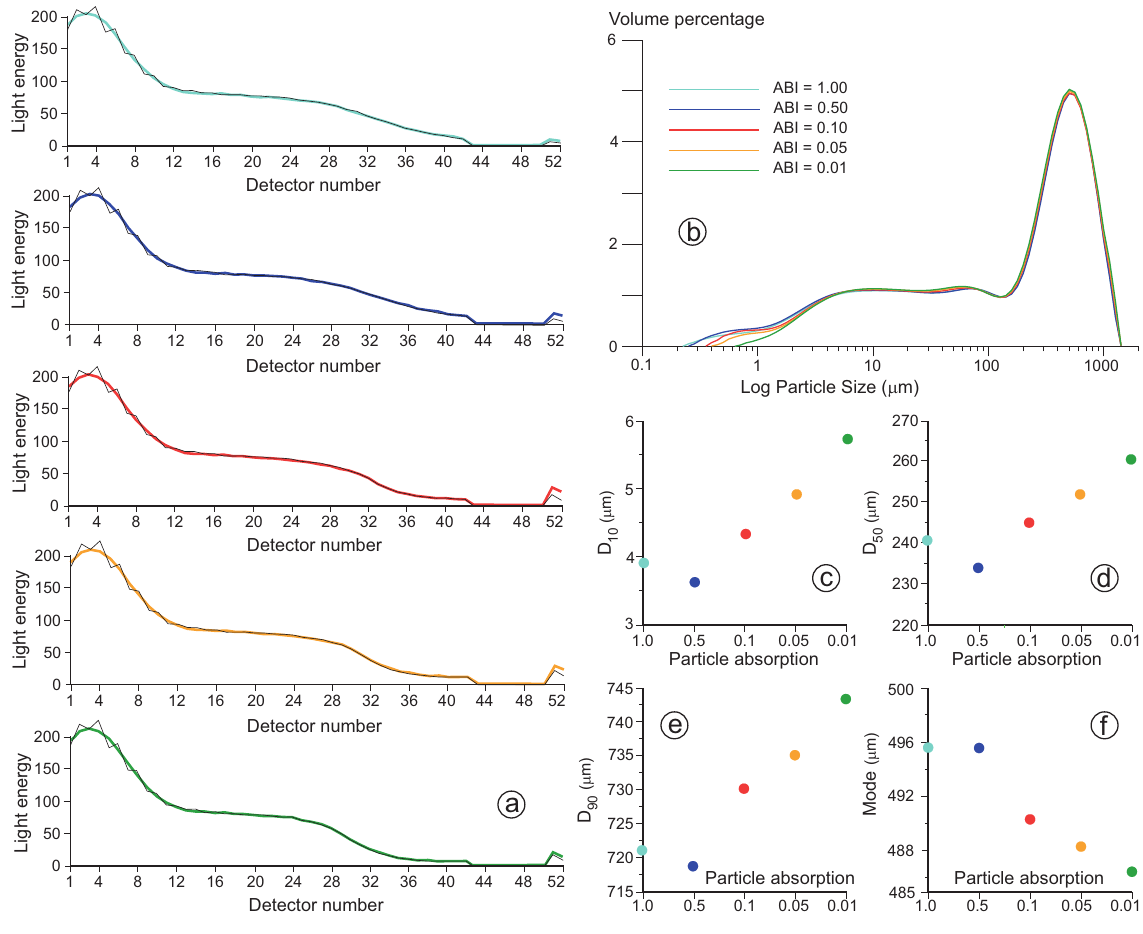
Fig. 23. Reprocessing of the first run data from test MP2000 5 on sub-sample aliquot CABRE3d (Fig. 9). (a) Light scattering data (black curve) and corresponding best fits for constant RI values of calcium carbonate=1.6, variable ABS values of calcium carbonate from 0.01 to 1.00 (colour code in (b)), and constant RI values of decalcified tap water=1.33. (b) Granulometric curves computed from reprocessed data in (a). (c) D 10 percentiles for data in the 5 curves illustrated in (b). (d) D 50 percentiles for data in the 5 curves illustrated in (b). (e) D 90 percentiles for data in the 5 curves illustrated in (b). (f) Modal values for data in the 5 curves illustrated in